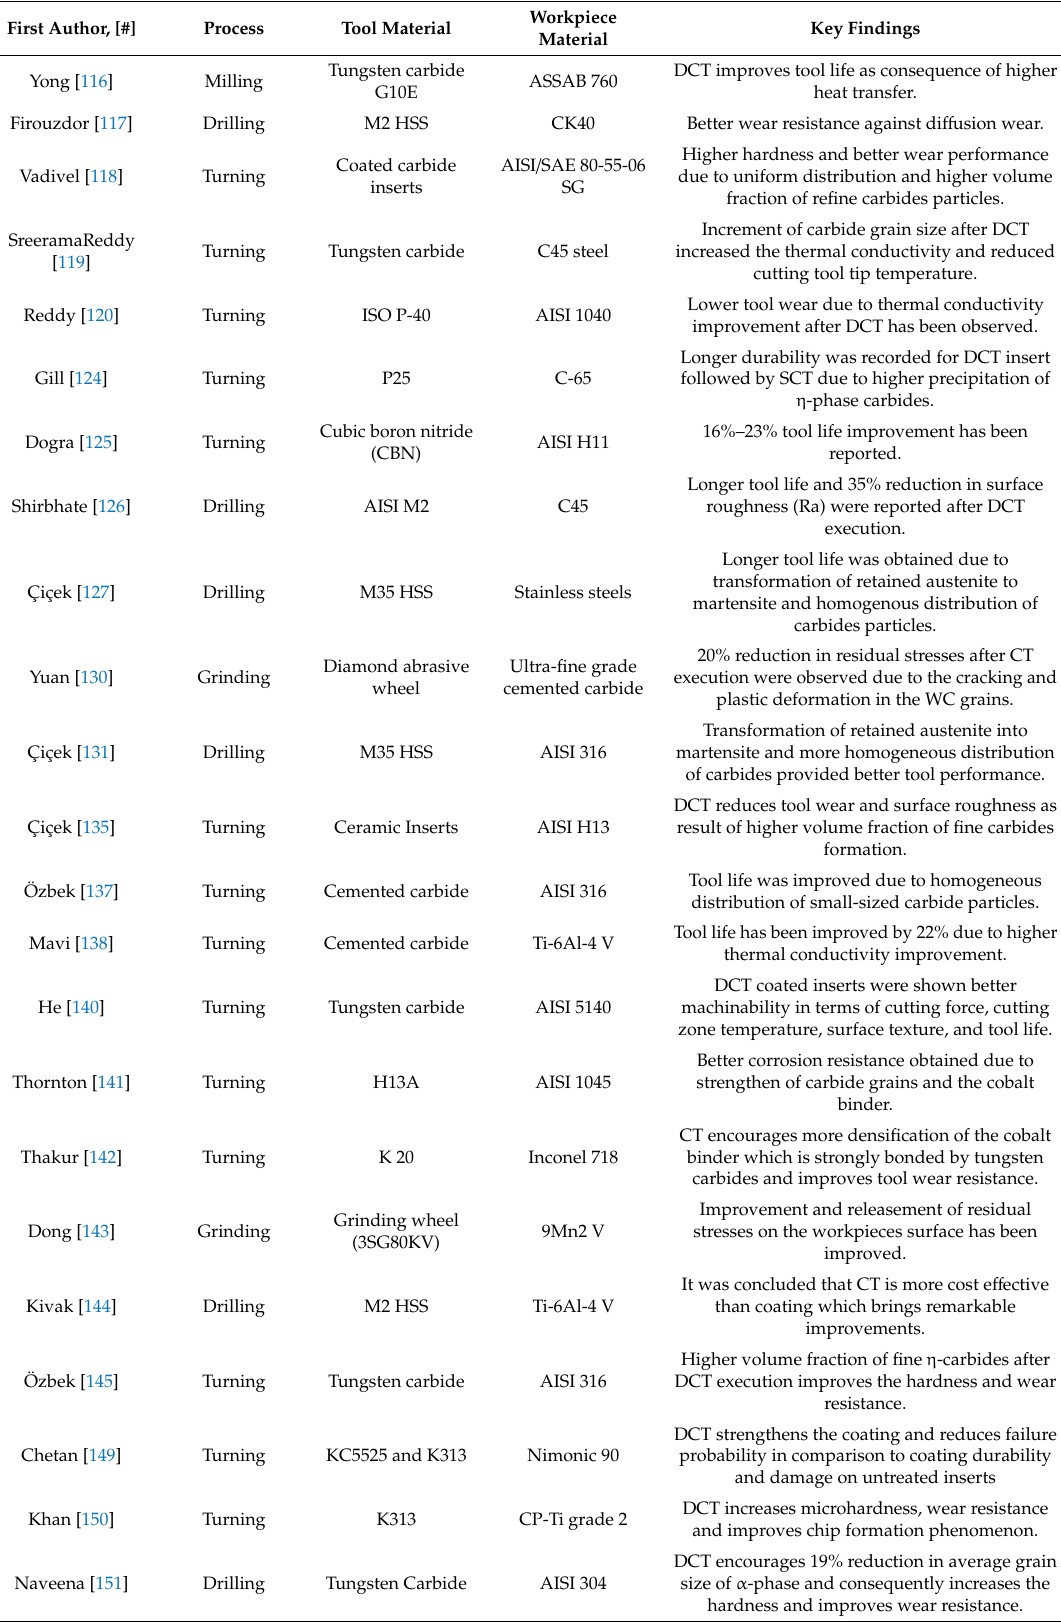
Table 5. Literature data related applying cryogenic treatment in conventional manufacturing